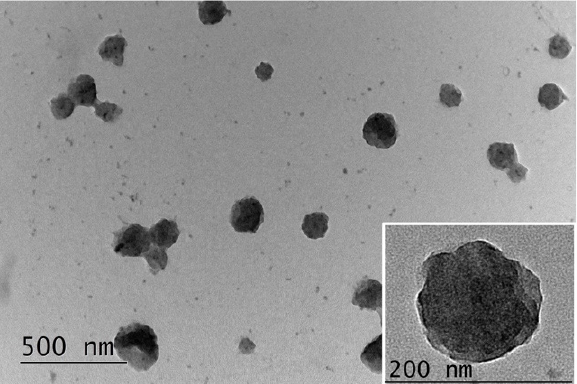
Figure 4. TEM images of PIC micelles formed from the oppositely charged hybrid block copolymers at molar ratio 1:1 (d = 118.07 ± 17 nm).